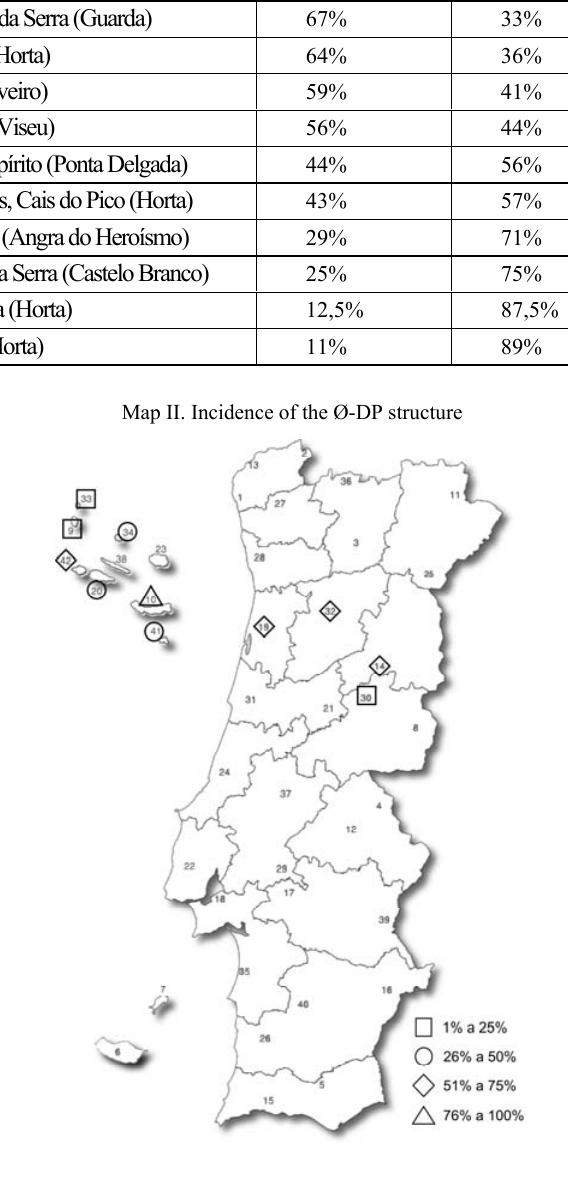
Ø-DP a -DP construction